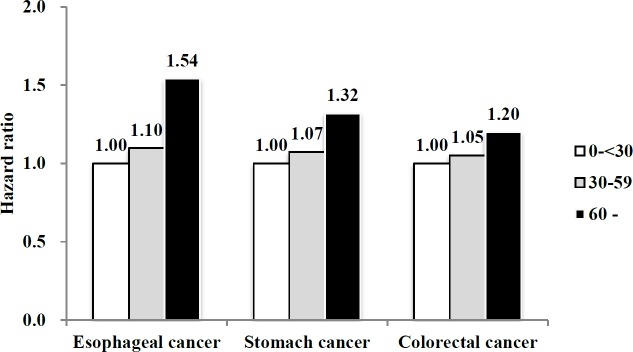
Hazard ratios for all-cause mortality according to FLI category in patients with esophageal, stomach, and colorectal cancer.Data are HRs (95% CI). All HRs adjusted for covariates including age, sex, smoking status, drinking habit, regular exercise, yearly income (lowest Q1), BMI, and diabetes.